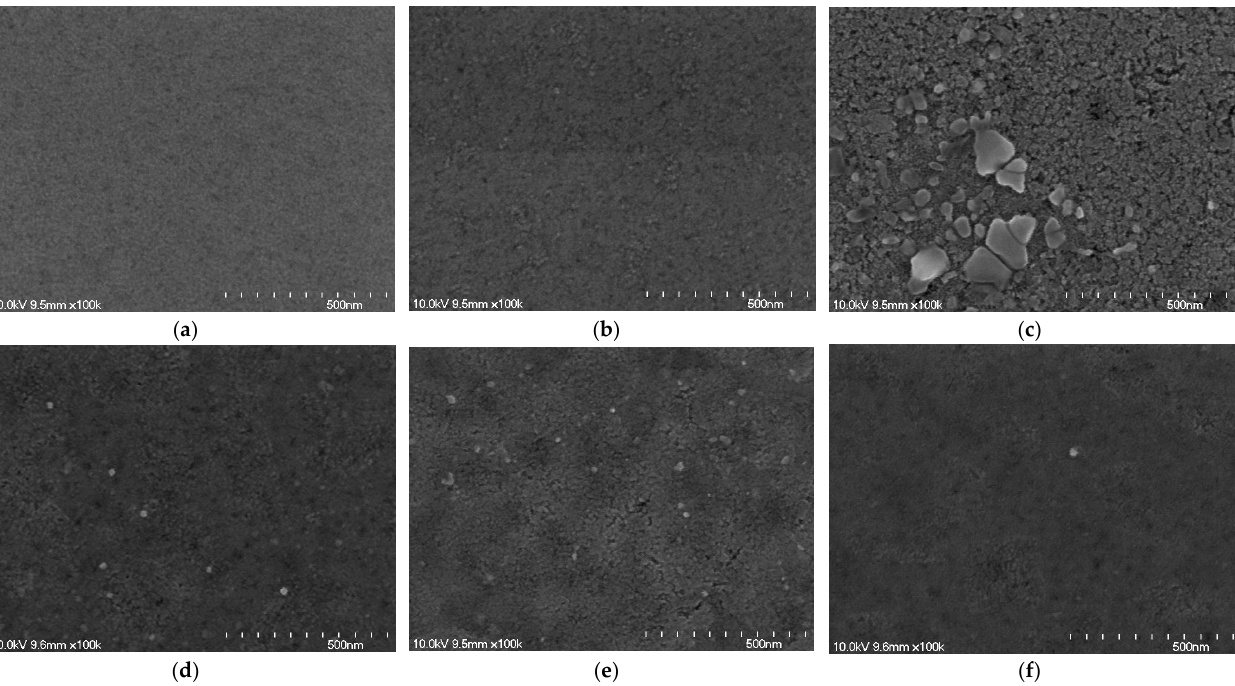
Figure 1. Top-view field emission scanning electron microscopy (FESEM) surface images of the CIGS:Te thin films with Te co-sputtering times of: ( a ) 0, ( b ) 270, ( c ) 510, ( d ) 750, ( e ) 945, and ( f ) 1140 s.